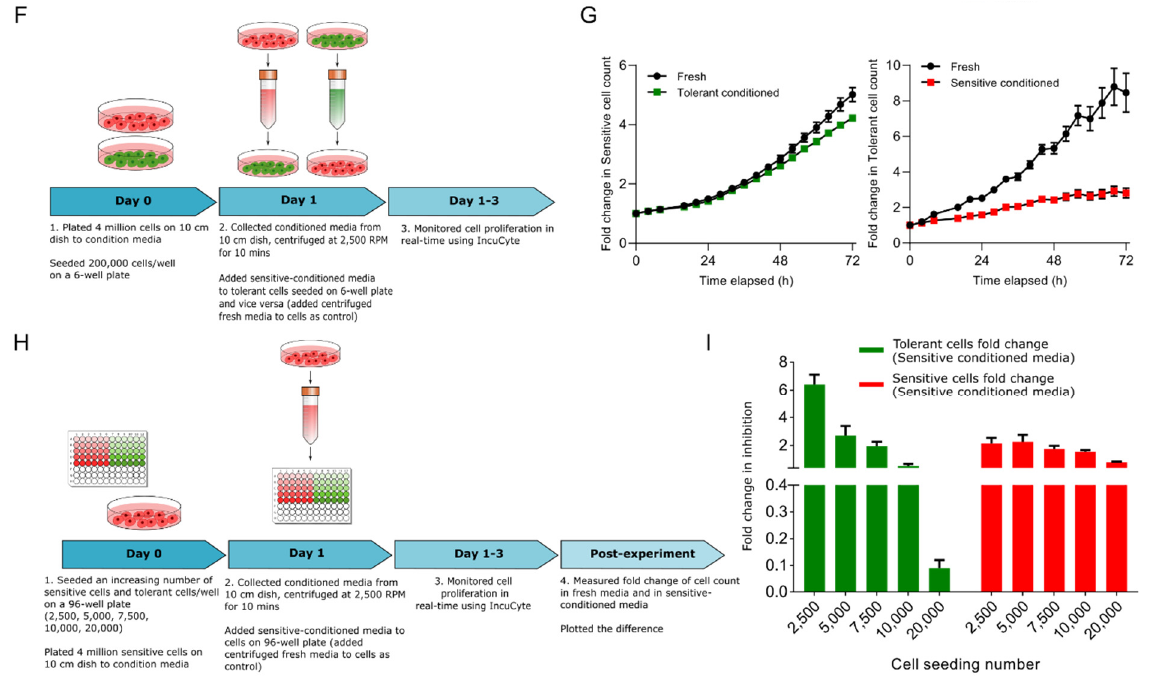
Figure 2. Behavior of cisplatin-sensitive (S) and tolerant (T) NSCLC cells in 2D co-culture. ( A ) Schematic representation of the experimental design of co-culturing S and T cells in a ratio of 1:1 and collection of data points. Proliferation of sensitive (red) and tolerant (green) cells under different culture conditions in the absence or presence of cisplatin. Two-way ANOVA test (multiple comparison) showing statistical significance **** p < 0.0001. ( B ) Sensitive and tolerant cells were plated in increasing T:S ratios and cultured for three weeks. Proliferation rate of sensitive cells (red) and tolerant cells (green) in heterotypic culture over the course of 144 h. ( C ) Fold change in cell count of sensitive cells (red) and tolerant cells (green) in heterotypic culture was measured after 144 h for